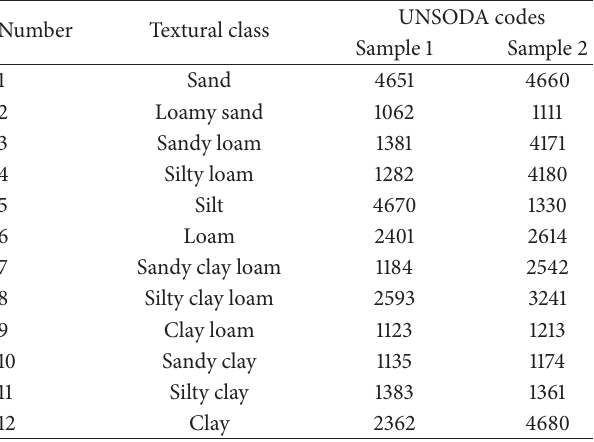
Table 2: Textural classes and UNSODA codes for soils used in this